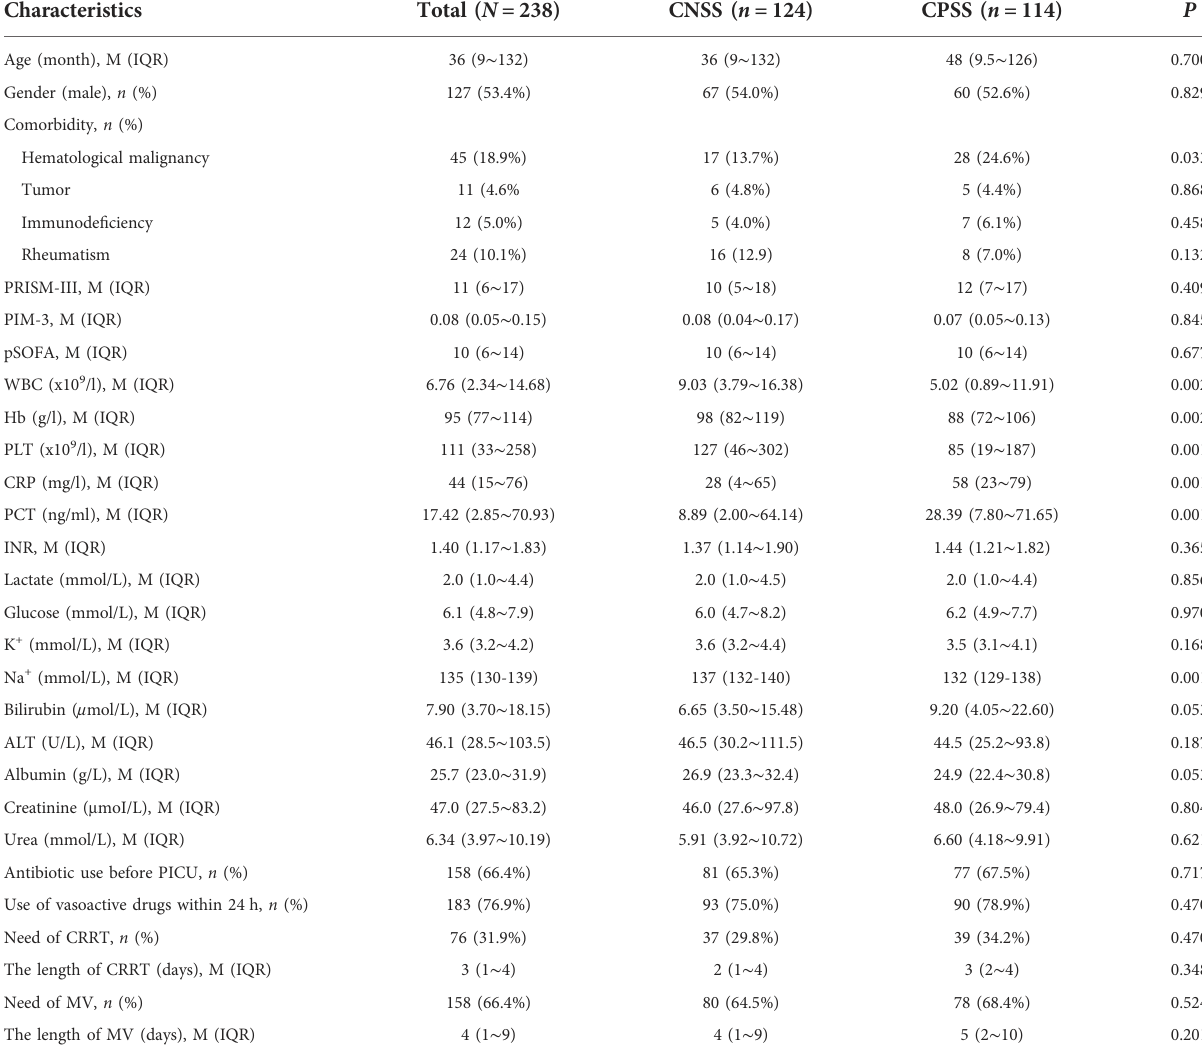
TABLE 1 Demographics, clinical characteristics of children with septic shock according to the culture results.